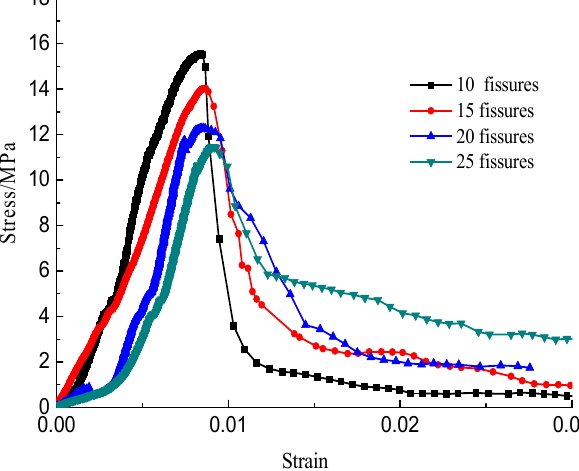
Figure 10. Stress–strain curves with a crack angle of 25°.